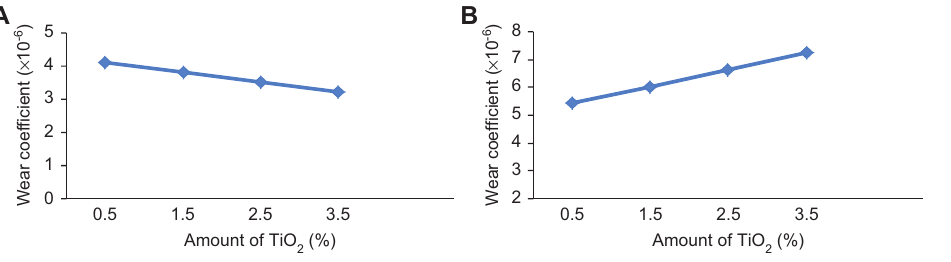
Figure 6 The variation of wear coefficients with increasing oxide addition in the composites developed by the addition of TiO removing debris and (B) without debris